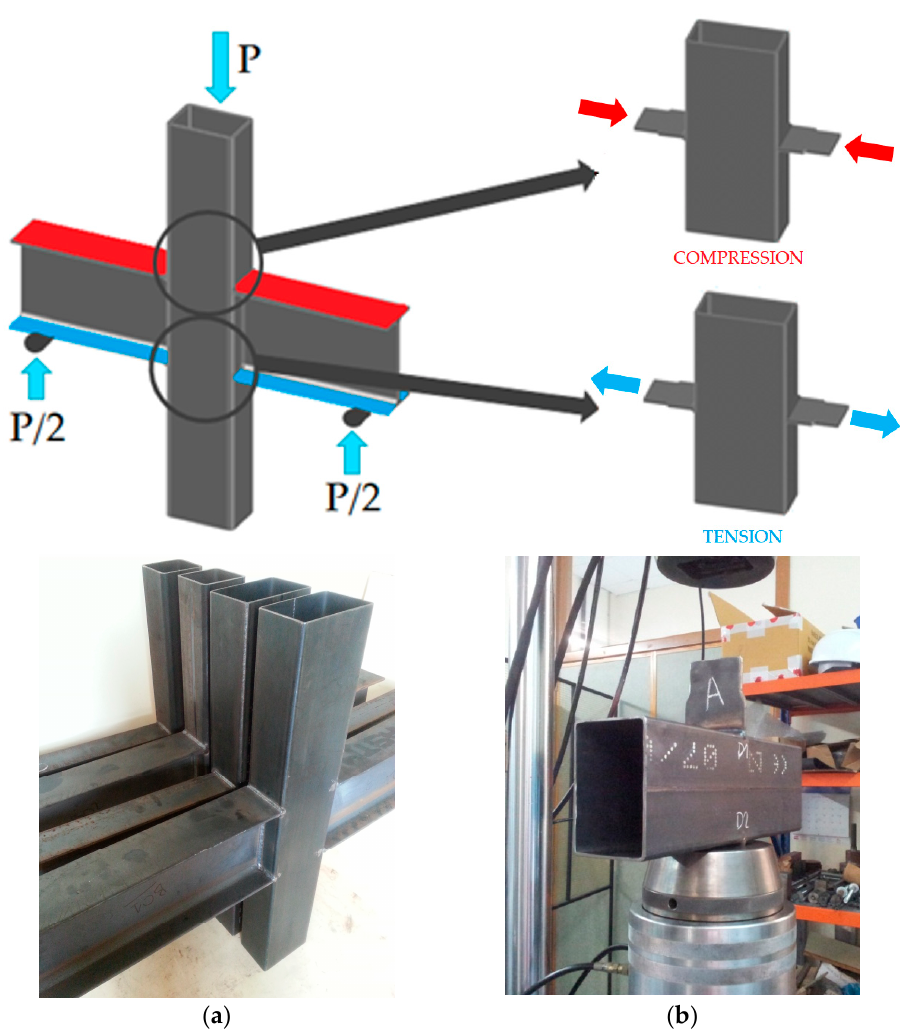
Figure 1. ( a ) Double-sided beam-to-column joints; ( b ) Double-sided lateral plate-to-tube joint.